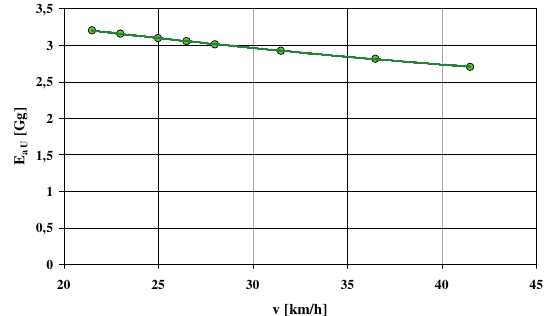
Fig. 10. Dependence of the national annual emission of particulate matter PM10 from tribological elements of passenger cars upon the average velocity, under model conditions of urban traffic